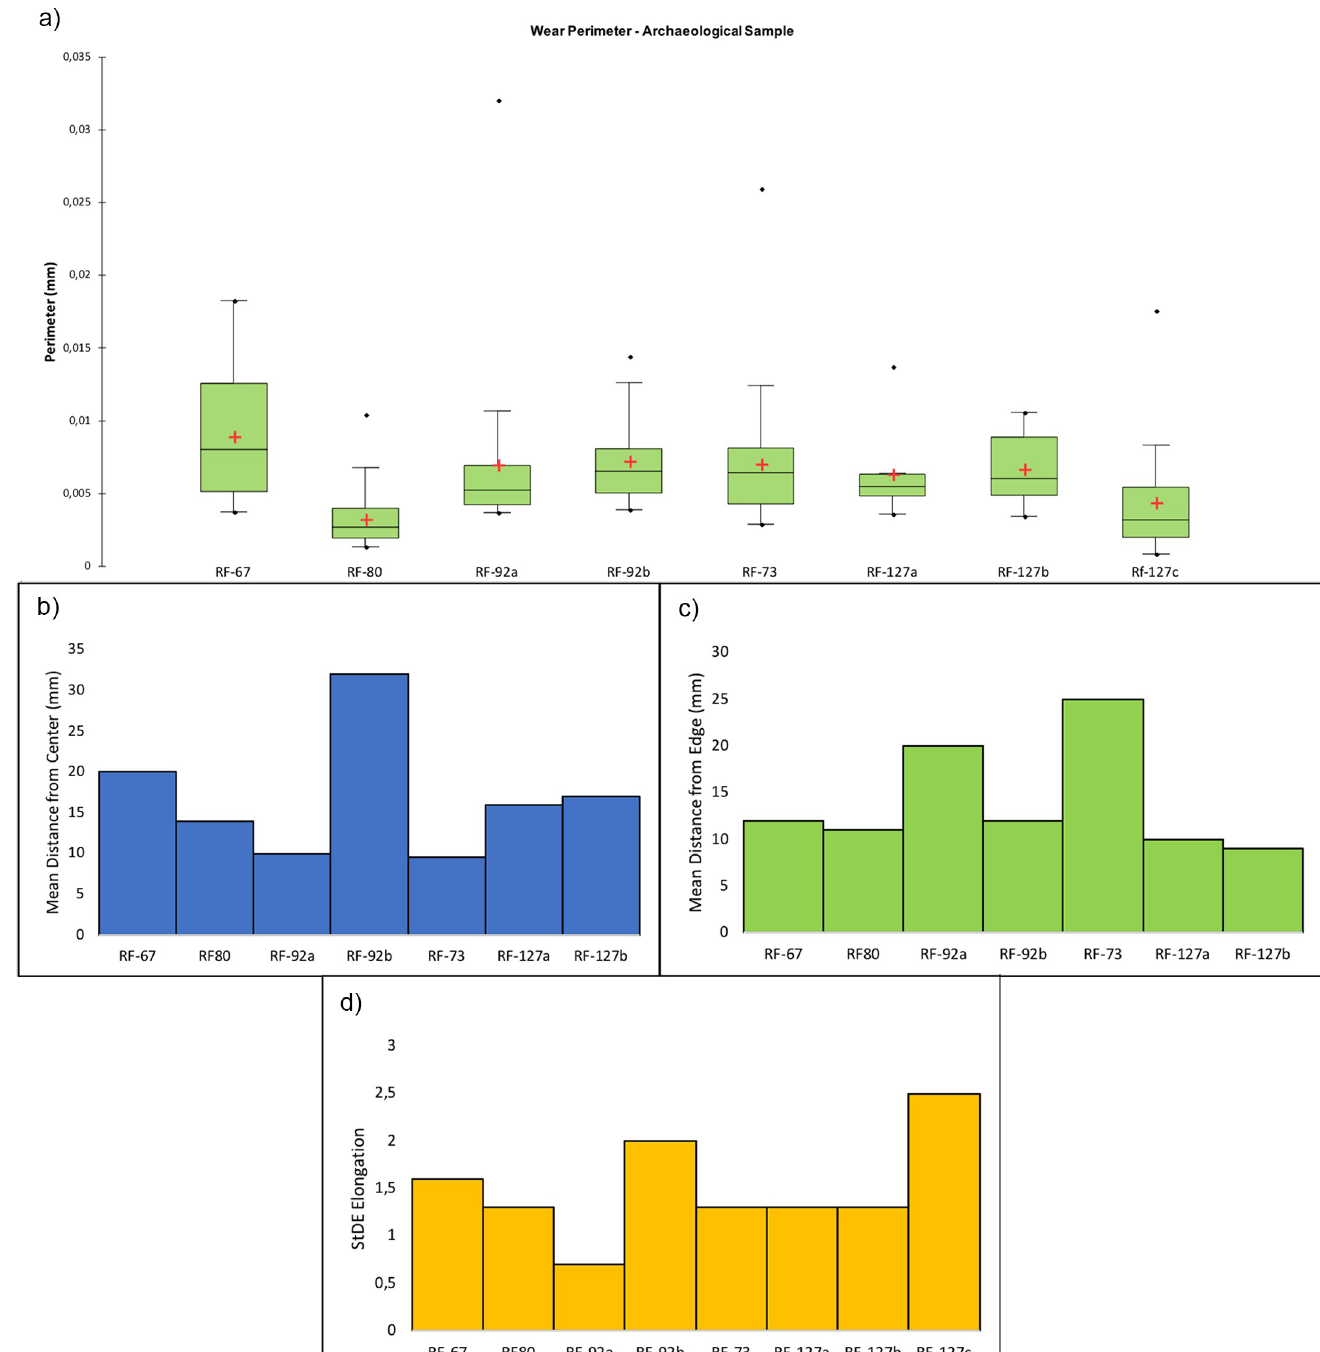
Fig 29. Archaeological specimens. (a) Dimension of the wear identified over the utilized areas; (b) mean distance of the identified wear from the object centre; (c) mean distance of the identified wear from the object edge; (d) dispersion of the identified wear over the tool surface defined by the elongation of the standard deviational